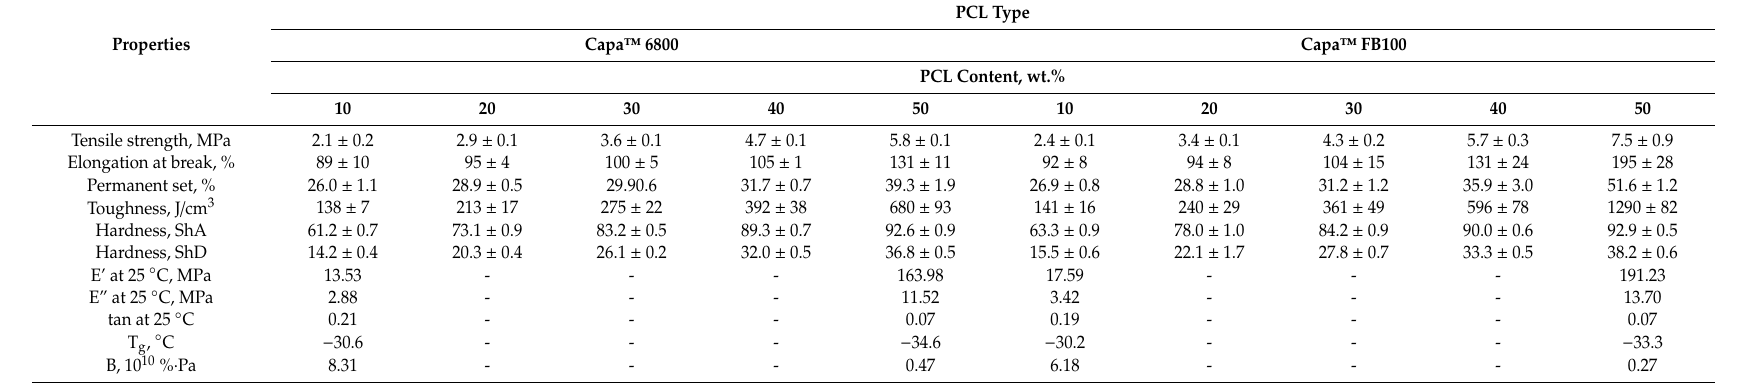
Table 3. Static and dynamic mechanical properties of RR / PCL